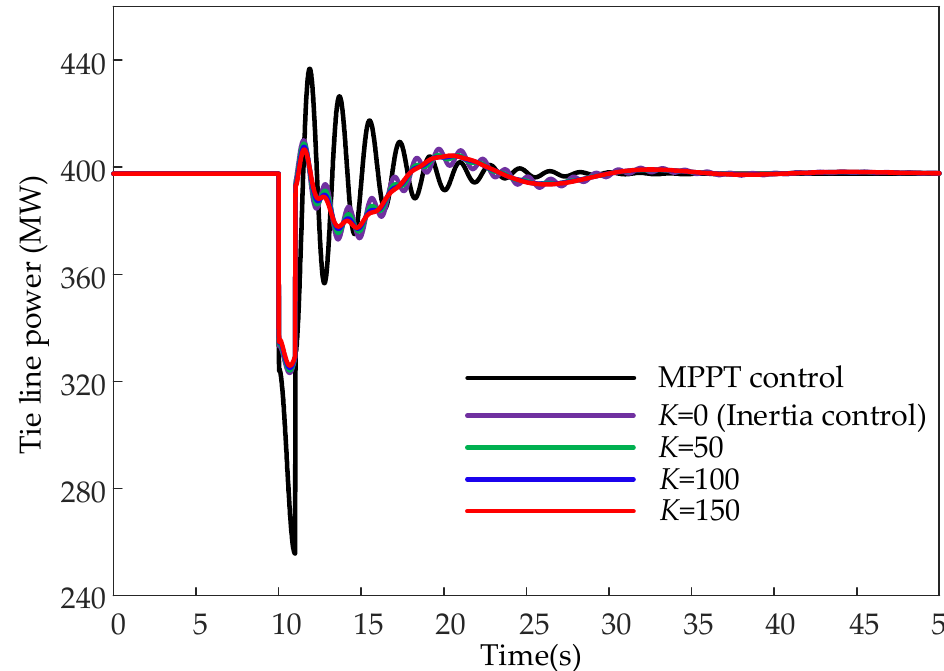
Figure 10. The response curves of tie-line power with different values of the damping control gain K ( K D = 40, K P = 10).